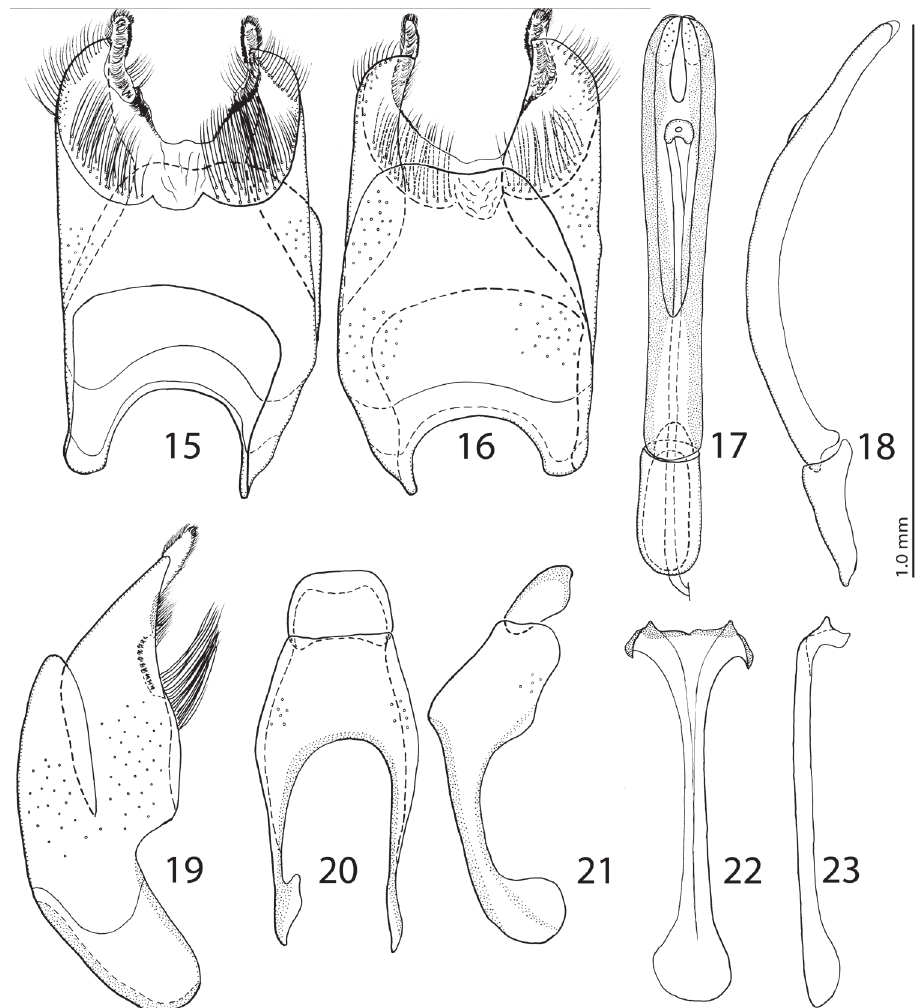
Figures 15–23. 15 Eremosaprinus warneri sp. n., 8 th sternite and tergite, ventral view. 16 ditto, dorsal view 17 Eremosaprinus warneri sp. n., aedeagus, dorsal view 18 ditto, lateral view 19 Eremosaprinus warneri sp. n., 8 th sternite and tergite, lateral view 20 Eremosaprinus warneri sp. n., 9 th + 10 th tergites, dor- sal view 21 ditto, lateral view 22 Eremosaprinus warneri sp. n., spiculum gastrale, ventral view 23 ditto, lateral